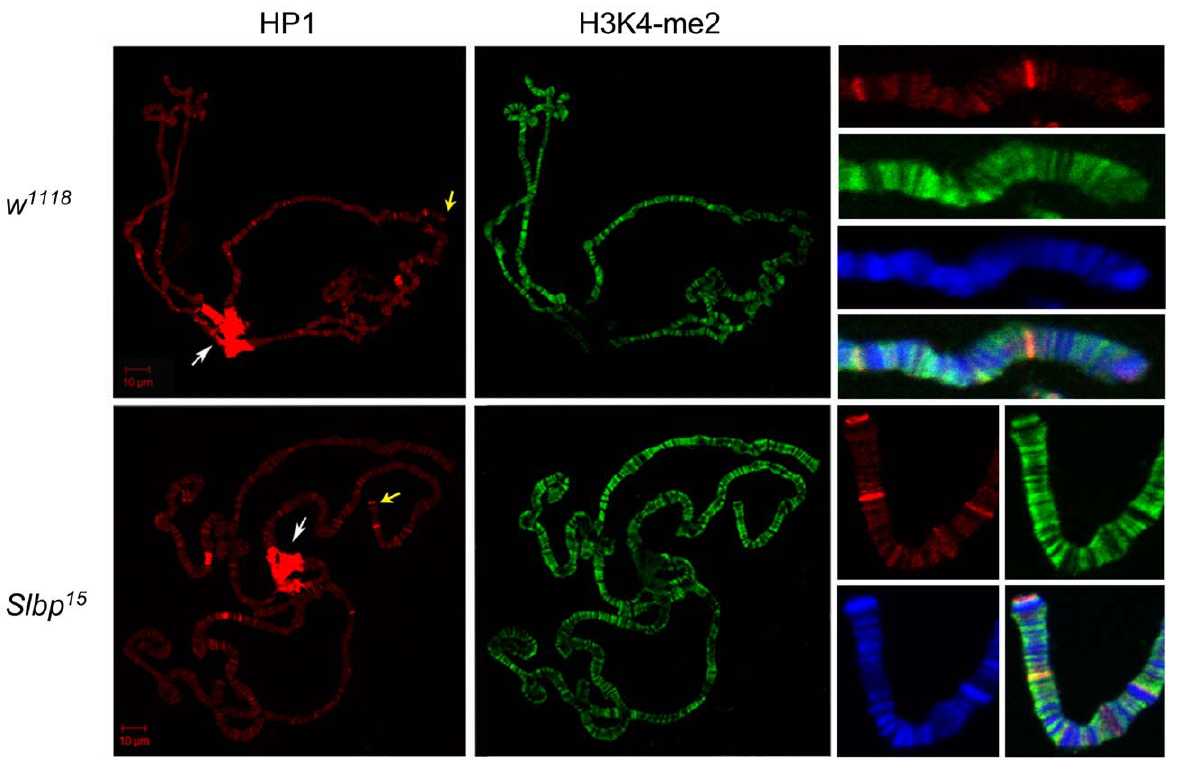
Figure 5. The global balance of euchromatin and heterochromatin remains unchanged in Slbp mutants. Polytene chromosome spreads of wt and Slbp 15 mutants were stained with antibodies for HP1 (red) and H3K4-me2 (green). DNA was stained with DAPI (blue). Leftmost panels are low magnification images of the entire genome. HP1 stains the chromocenter (white arrows) and telomeres, as well as other heterochromatic bands. Rightmost panels are high magnification images of a single homologous stretch of autosome for each genotype. Position of high magnification images are indicated on low magnification images with yellow arrows.